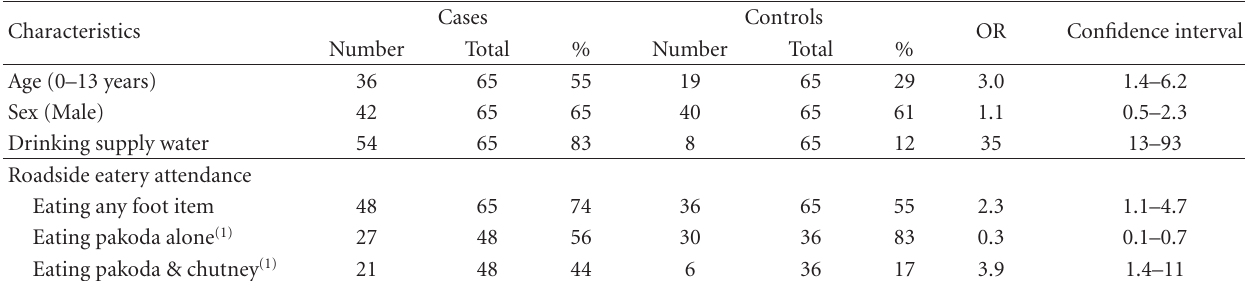
Table 2: Characteristics of organophosphorous poisoning cases and controls, Sindhikela, Bolangir, Orissa, India, 2008. Characteristics